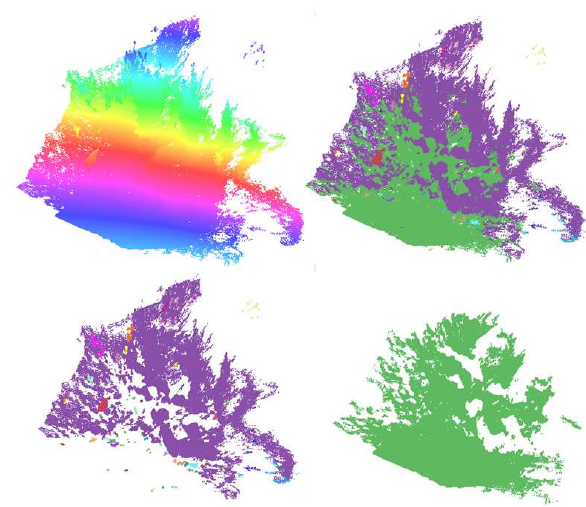
Figure 7. Point cloud generated Agisoft (upper left), segmentation result (upper right), divided into above ground components (bottom left) and the rock surface (bottom right)